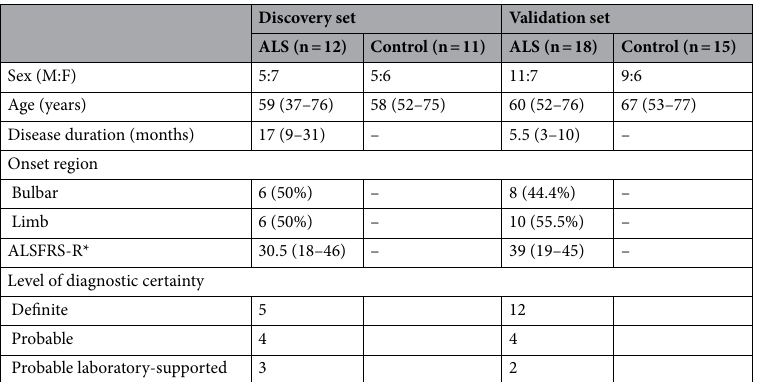
Table 1. Clinical features of study participants. Data are expressed as median value (min–max). ALS amyotrophic lateral sclerosis, M male, F female, ALSFRS-R ALS functional rating scale-revised.